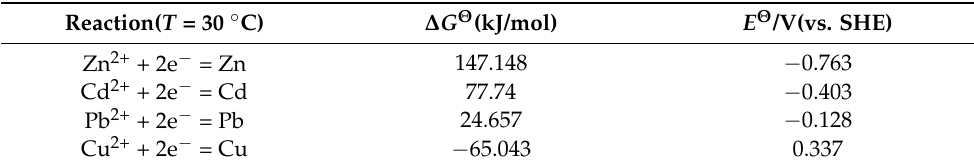
Figure 2. Cyclic voltammetry graph ( T = 30 °C; WE: Glassy Carbon Electrode; CE: Platinum; RE: Hg/HgO (0.098 V) scan rate: 0.1 V/s). Table 3. Standard electrode potential for different reactions.